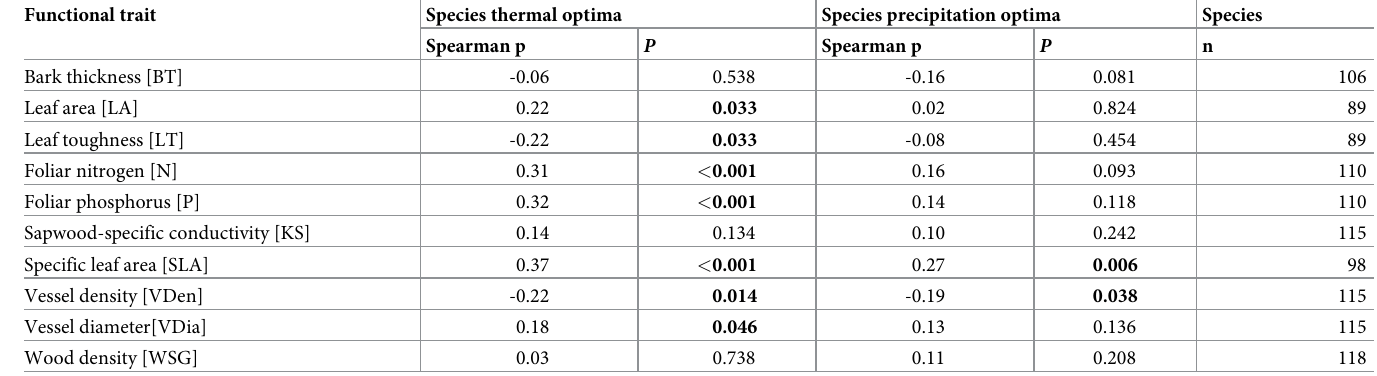
Table 2. Non-parametric correlations between species functional traits, and species climatic optima, and number of species included in the respective analyses. Sta- tistically significant values are presented in bold. Functional trait